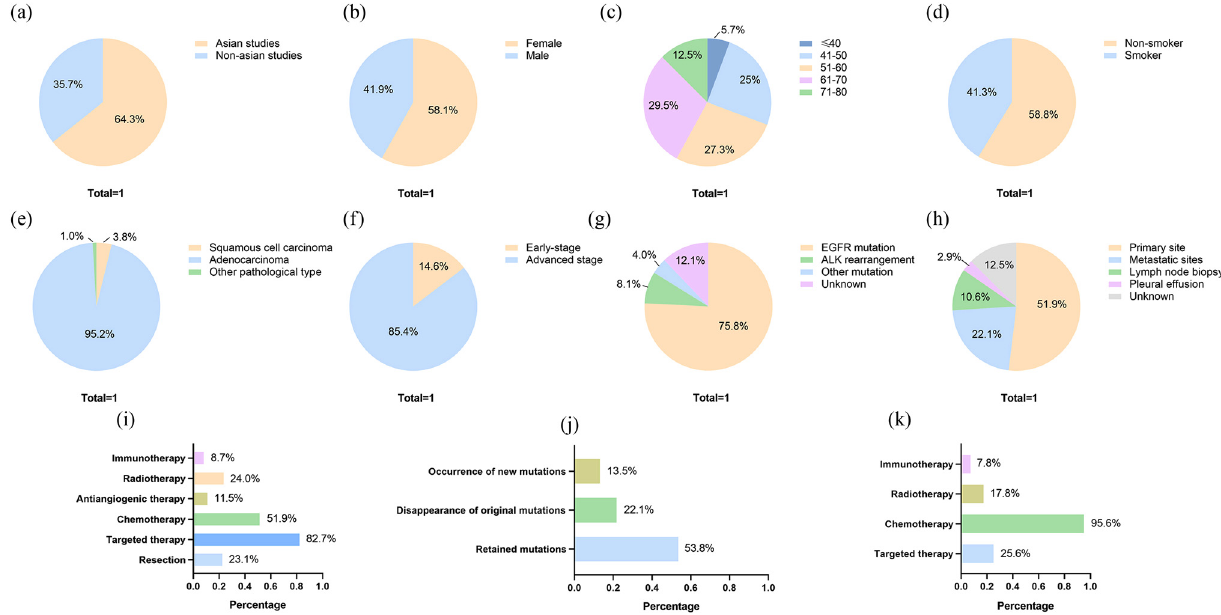
Figure 2: Clinical characteristics of patients. ( a ) Published countries of studies. ( b ) Gender information of patients. ( c ) Age of patients. ( d ) Smoking history of patients. ( e ) Pathological type of patients. ( f ) Stage information of patients. ( g ) Mutations of patients with adenocarcinoma. ( h ) Re - biopsy sites of patients. ( i ) Treatments before transformation. ( j ) Mutations in re - biopsy. ( k ) Treatments after